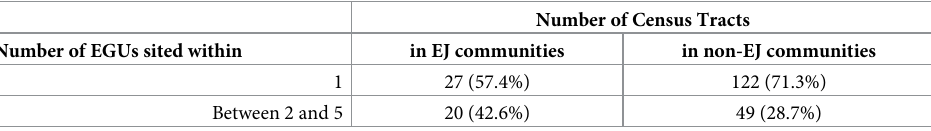
Table 2. Number of census tracts with one and between 2–5 EGUs sited within EJCs and non-EJCs communities in